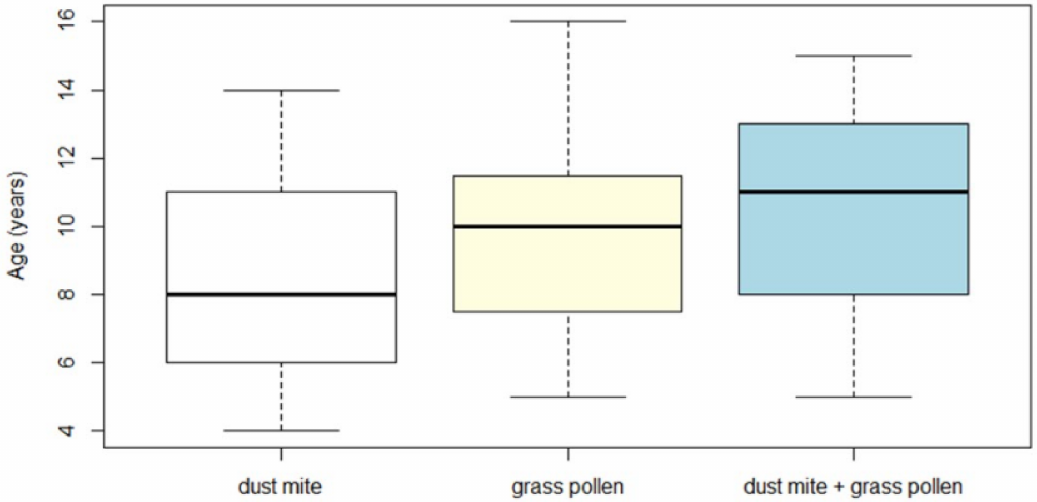
Figure 1. Age distribution of the enrolled children depending on the type of allergy (dust mite, grass pollen, dust mite + grass